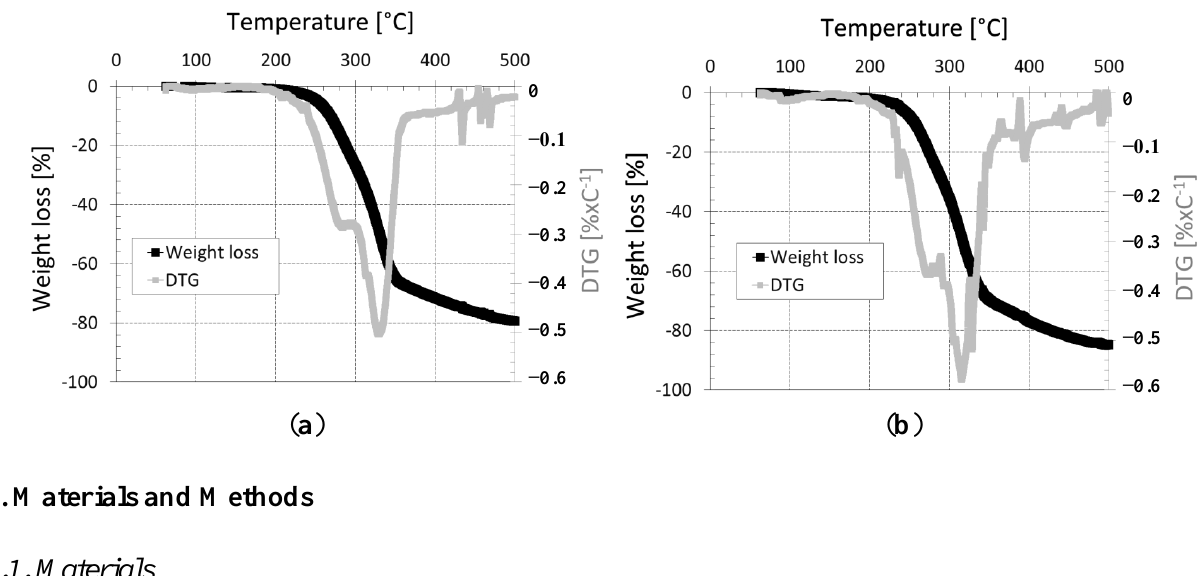
Figure 7. ATG and DTG analysis ( a ) wheat straw; ( b ) barley